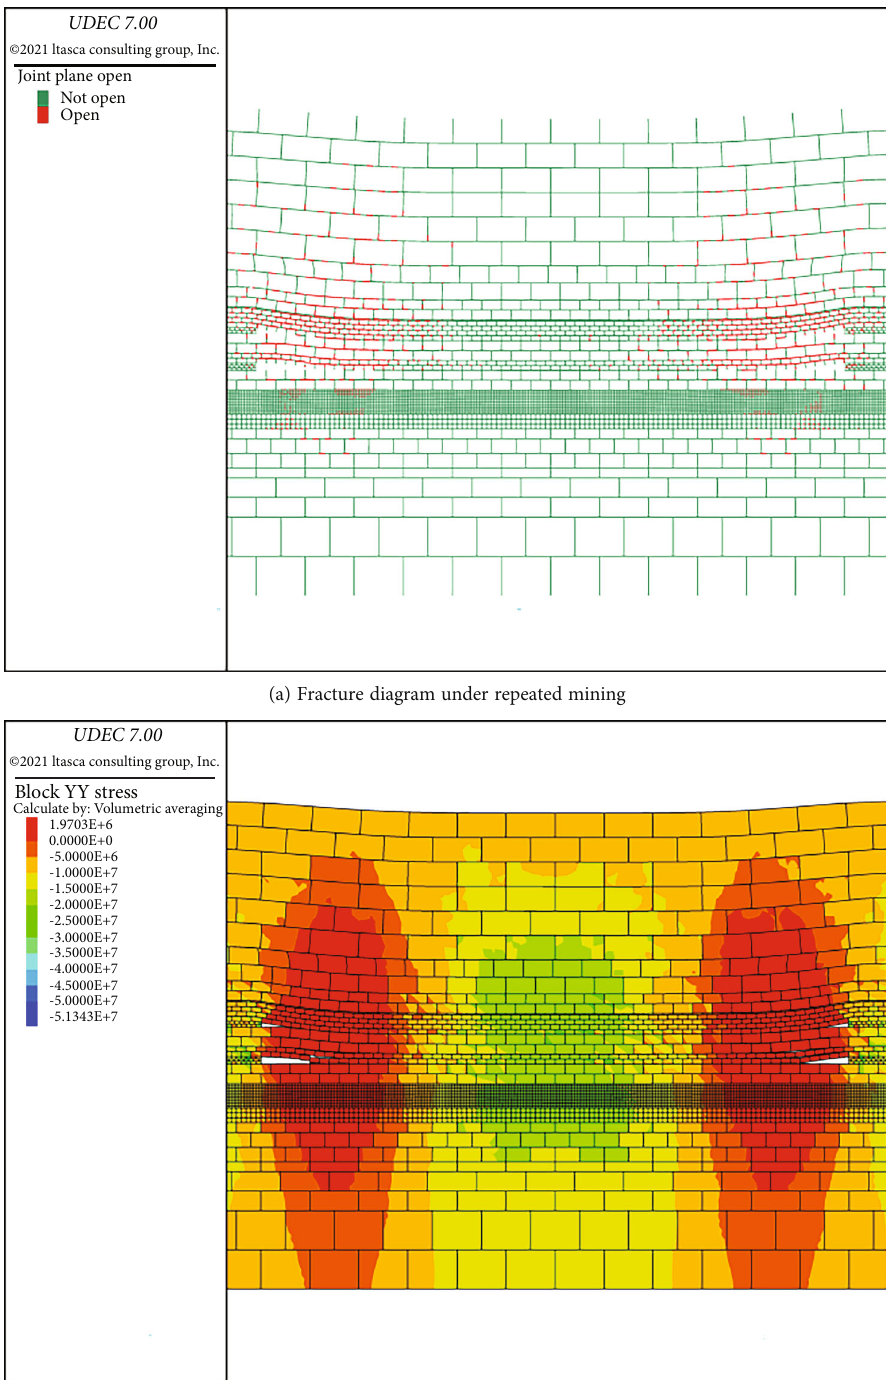
Figure 17: Fracture-stress evolution after mining of 15# and 16# coal